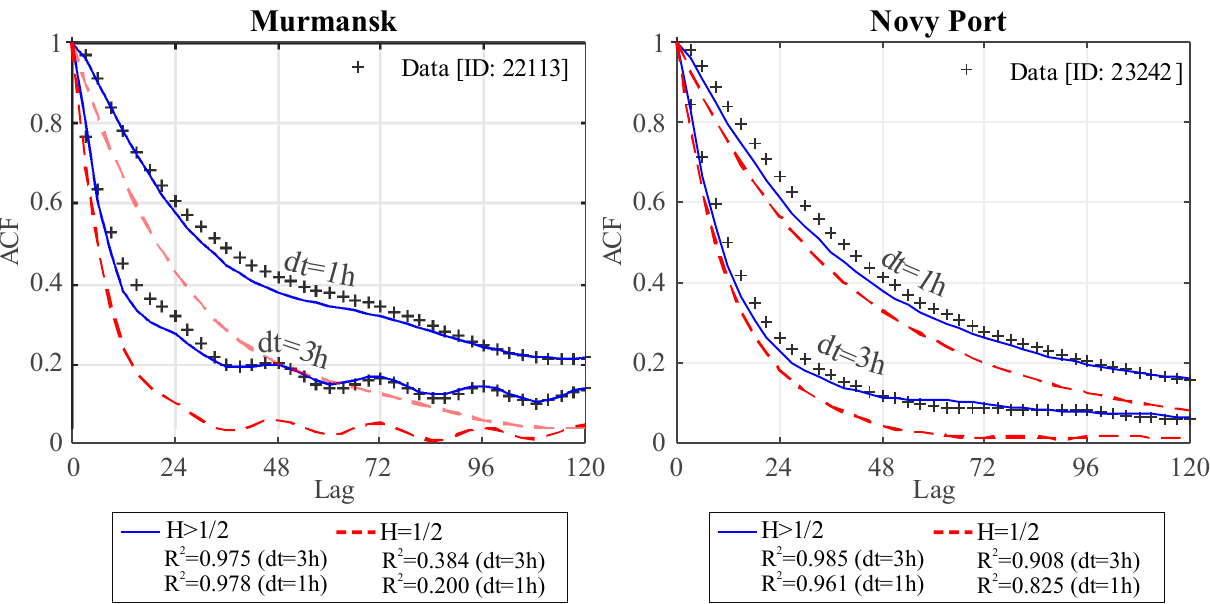
Figure 7. Autocorrelation of observed and simulated wind speed data.